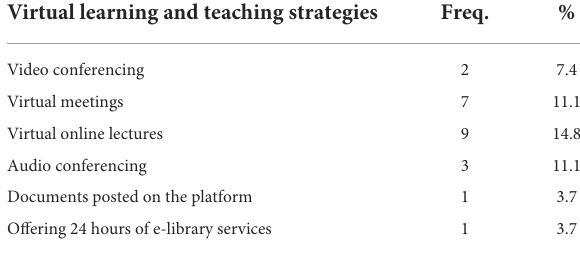
TABLE 7 Adaptation behavior before the COVID-19 pandemic. TABLE 8 Strategies adopted by different institutions.